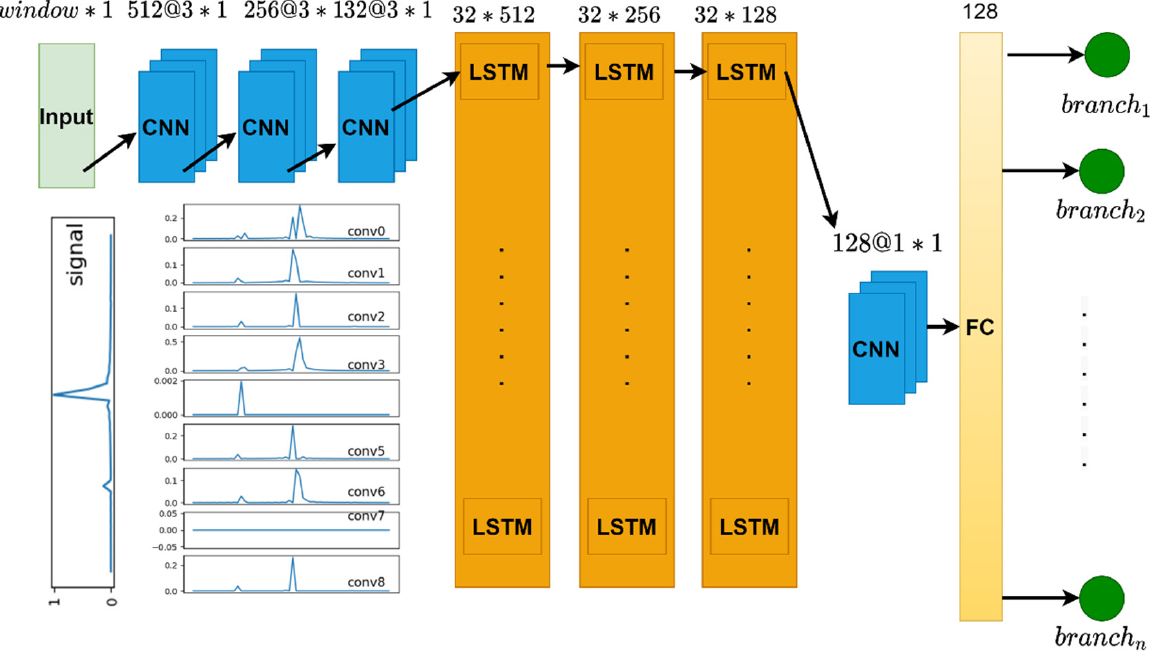
Figure 4. The proposed LSTM model.